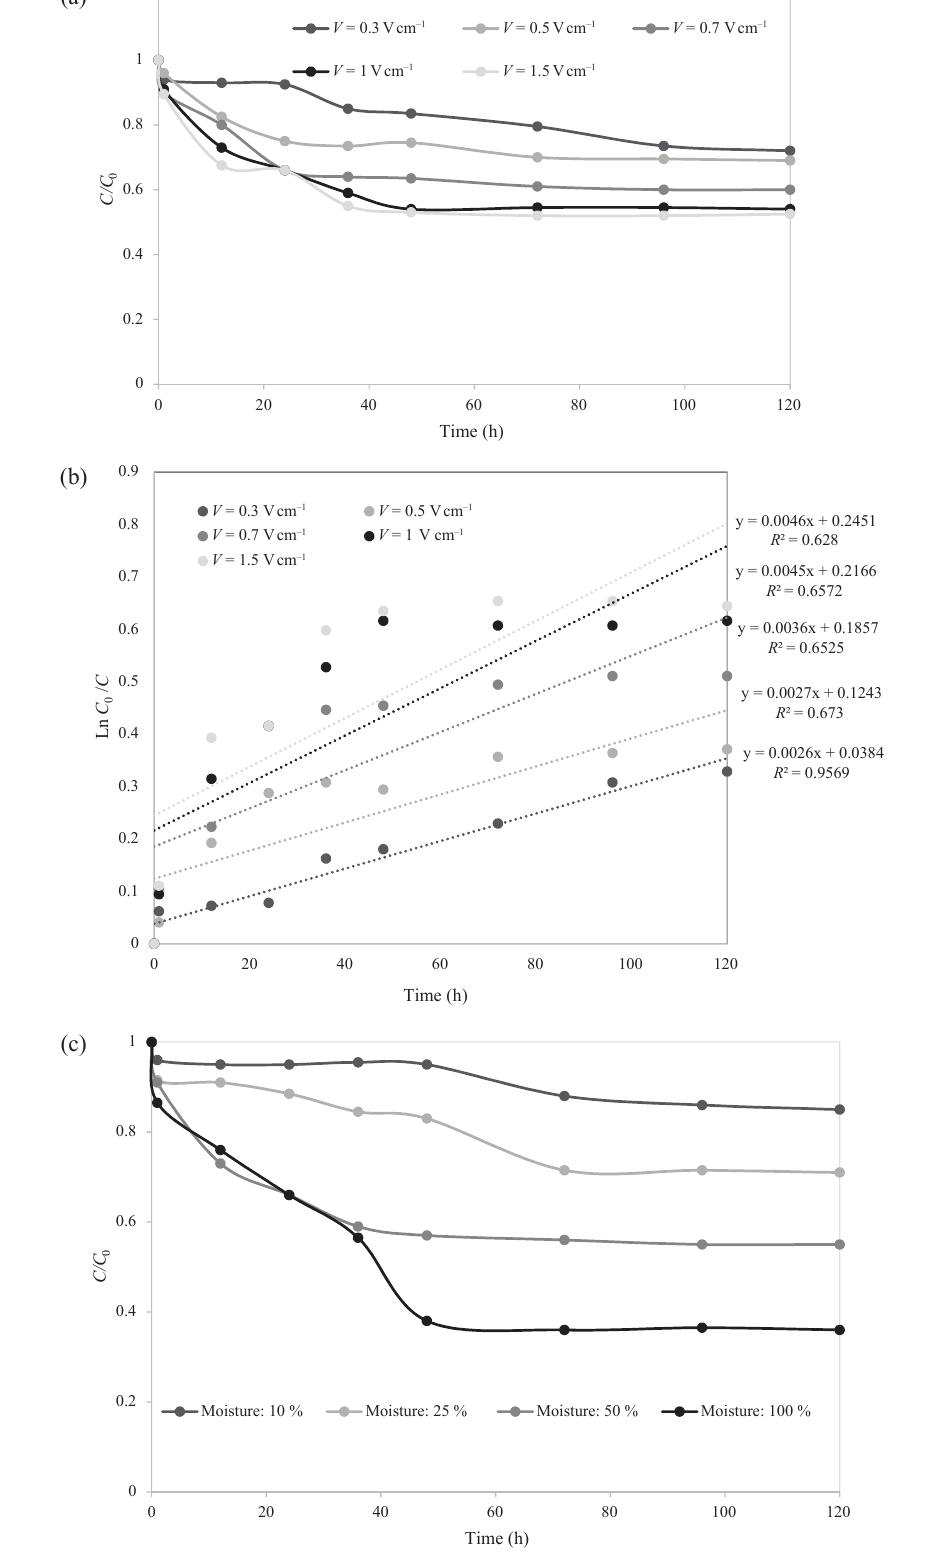
Fig. 1 – Effect of operating parameters on pyrene removal through EK remediation; initial pyrene: 200 mg kg –1 , pH: 7 ± 0.5, reaction time: 120 h, a) effect of voltage variations, and b) pseudo-first-order kinetic modeling, Tween 80: 0 mg kg –1 , persulfate: 0 mg kg –1 , moisture: 50 %, c) effect of moisture content, and d) pseudo-first-order kinetic modeling, Tween 80: 0 mg kg –1 , persulfate: 0 mg kg –1 , voltage: 1 V cm –1 , e) effect of Tween 80, and f) pseudo-first-order kinetic modeling, persulfate: 0 mg kg –1 ,